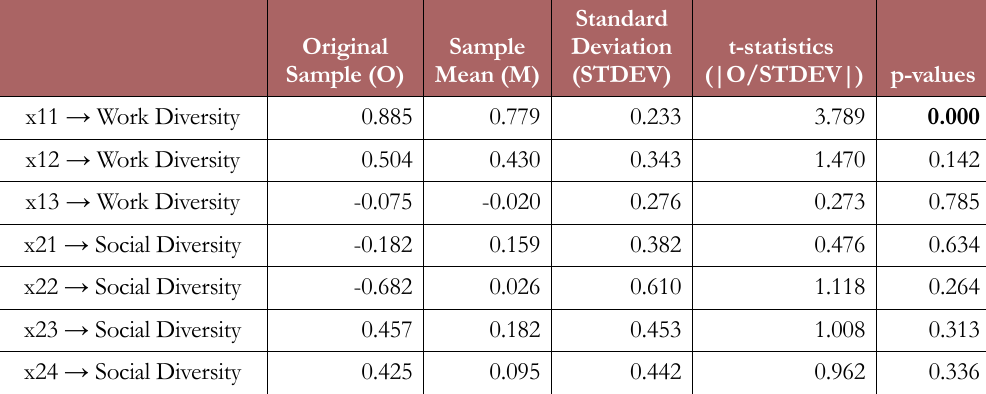
Table 8 . Outer Weight for Formative